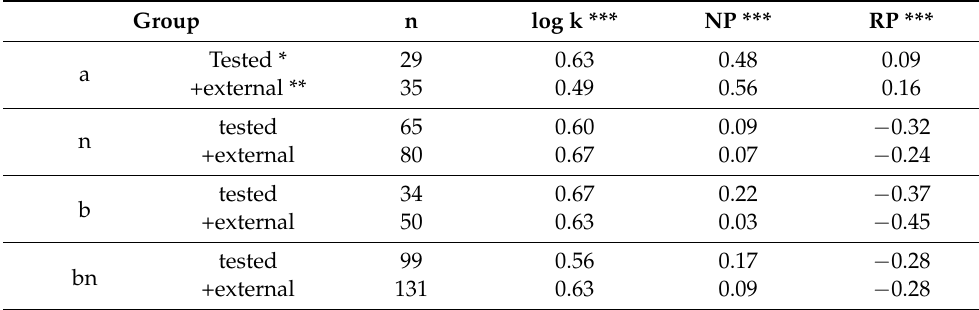
Table 5. Correlation of chromatographic parameters (log k and R f from NP and RP TLC) with protein binding values. Relations were made for originally tested APIs (129 drugs) and for enlarged groups with external cases (+38